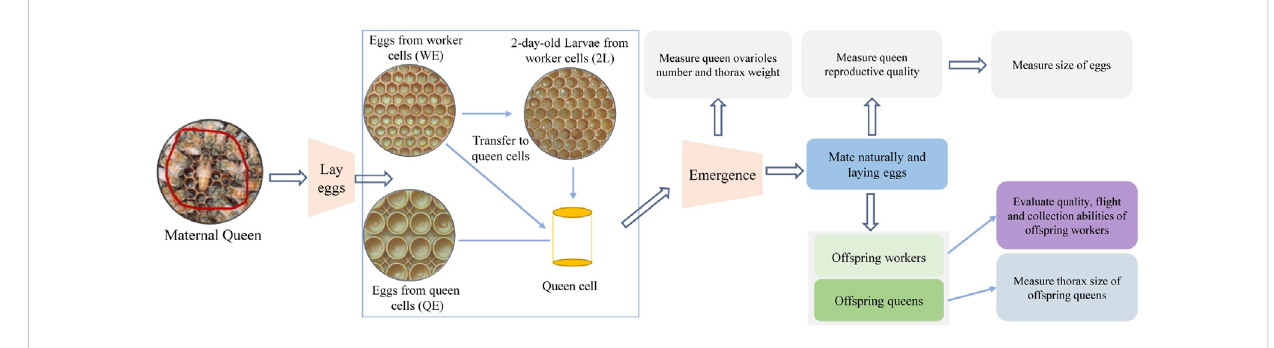
FIGURE 1 The fl ow chart of the